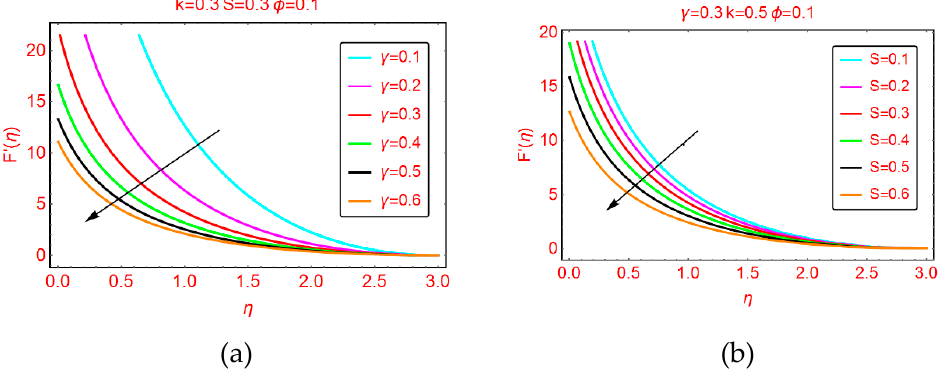
Figure 1. The velocity distribution for varying ( a ) γ and ( b ) S .